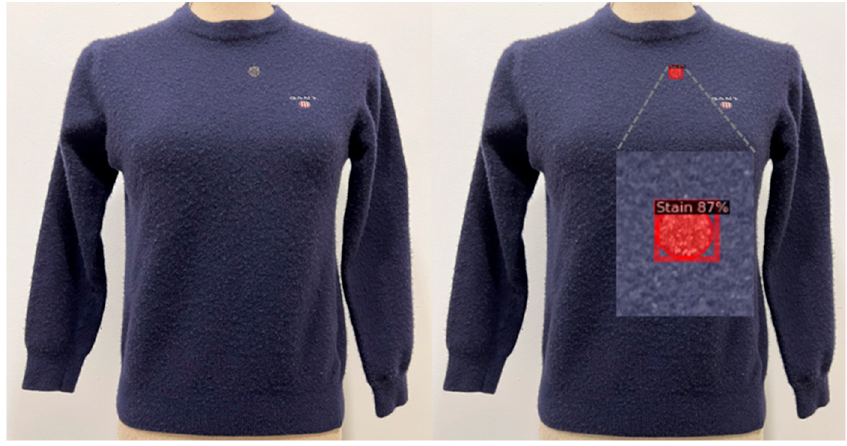
Figure 7. Stain detection with the corresponding class label, bounding box and pixel-level identification. Table 11. Summary of model losses. Table 10. Results from Common Objects in Context (COCO) evaluator. Network AP AP at IoU = 0.50 AP at IoU = 0.75